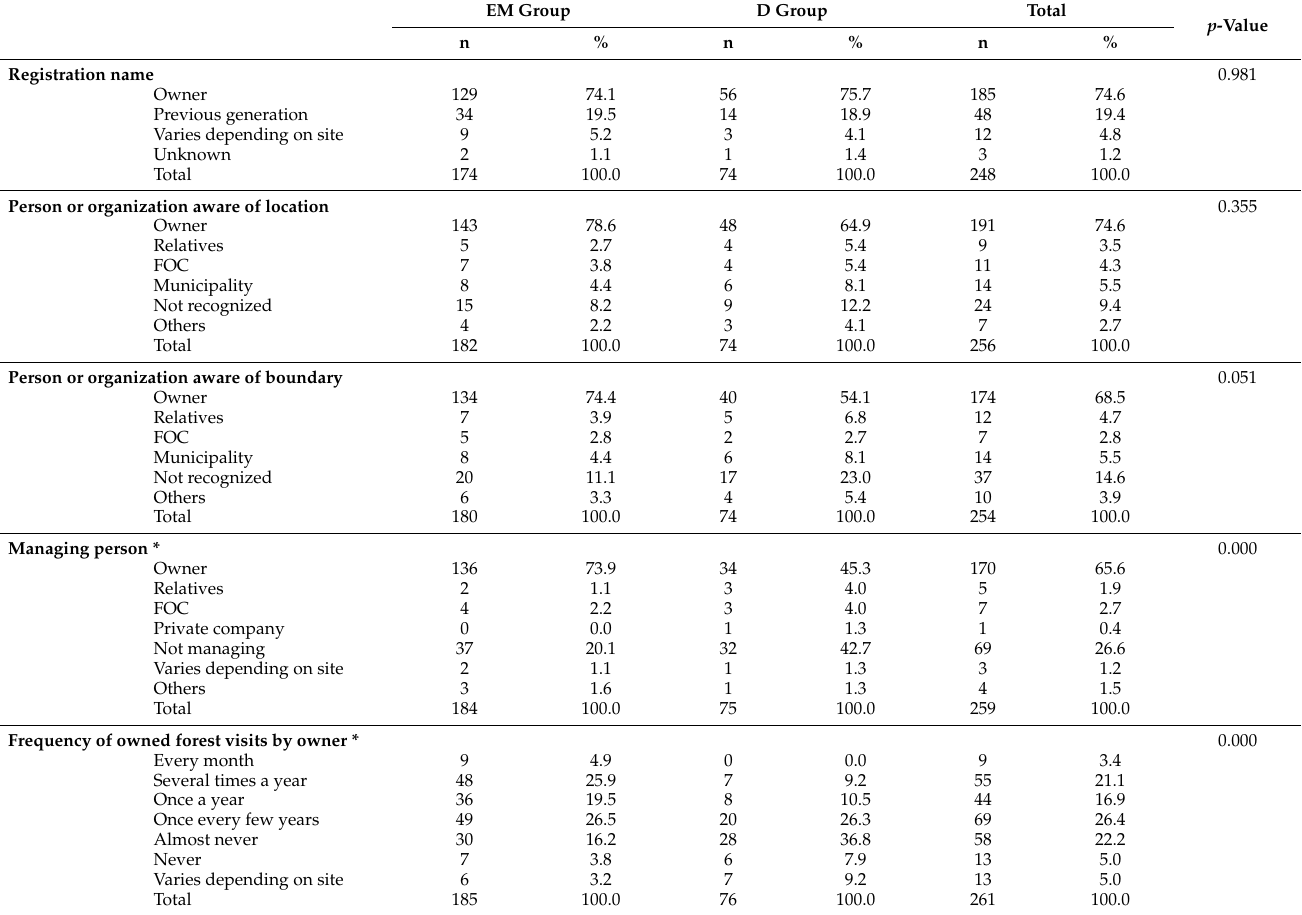
Table 10. Comparison of forest management behaviors between the two groups in Kitakata. EM